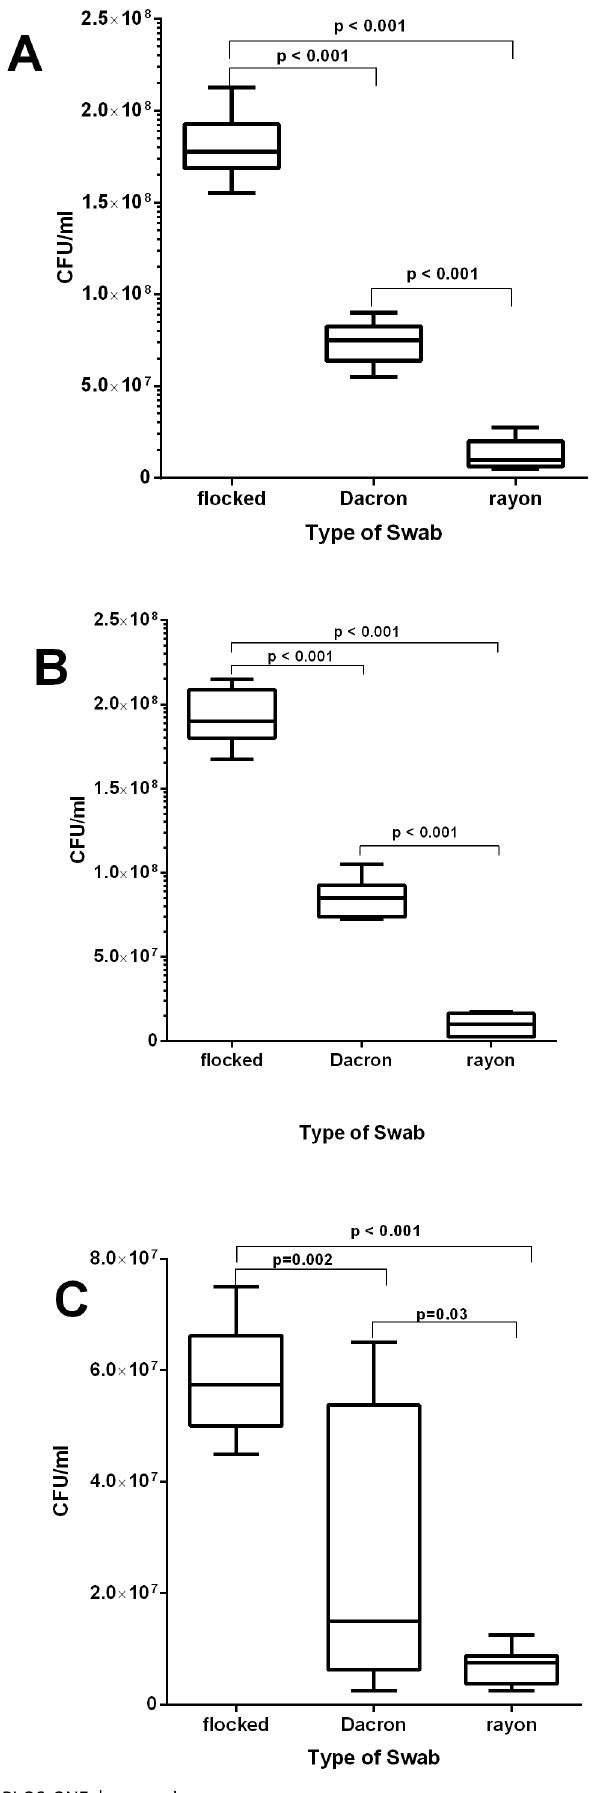
Figure 1. Recovery of Streptococcus pneumoniae from mock specimens using flocked, Dacron and rayon swabs. The data is presented as the pooled mean CFU recovered from 9 replicate of each swab type using S.pneumoniae serotype 19F (Fig 1A), serotype 1 (Fig 1B) or serotype 5 (Fig 1C). An unpaired student t-test was used for statistical